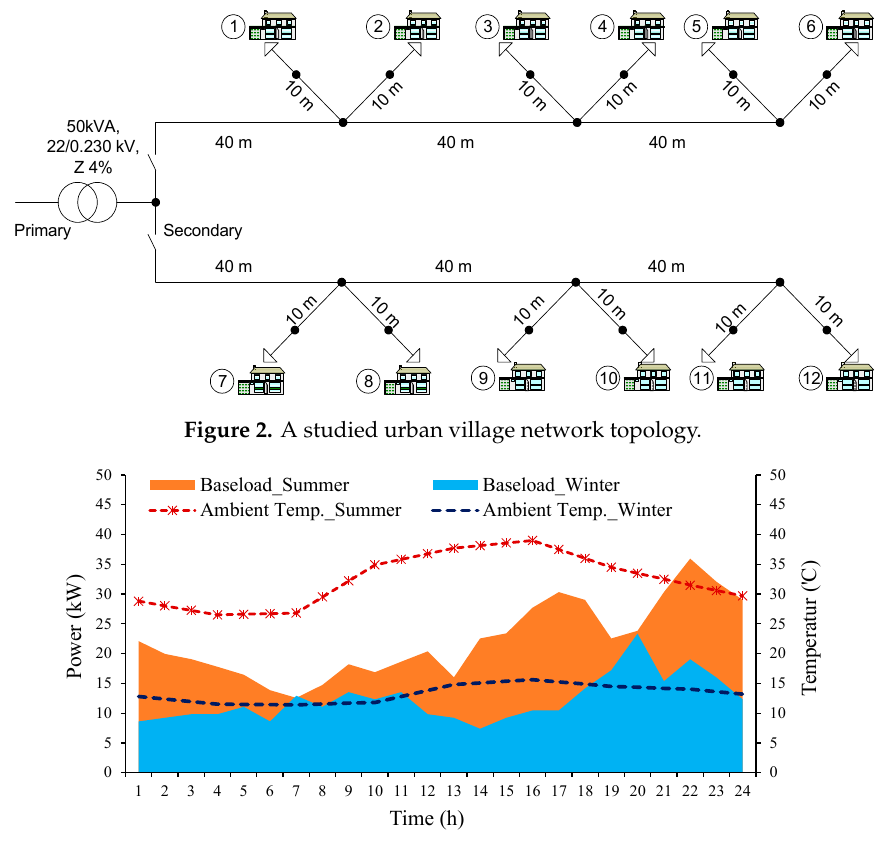
Figure 3. Village baseload and ambient temperature profiles.